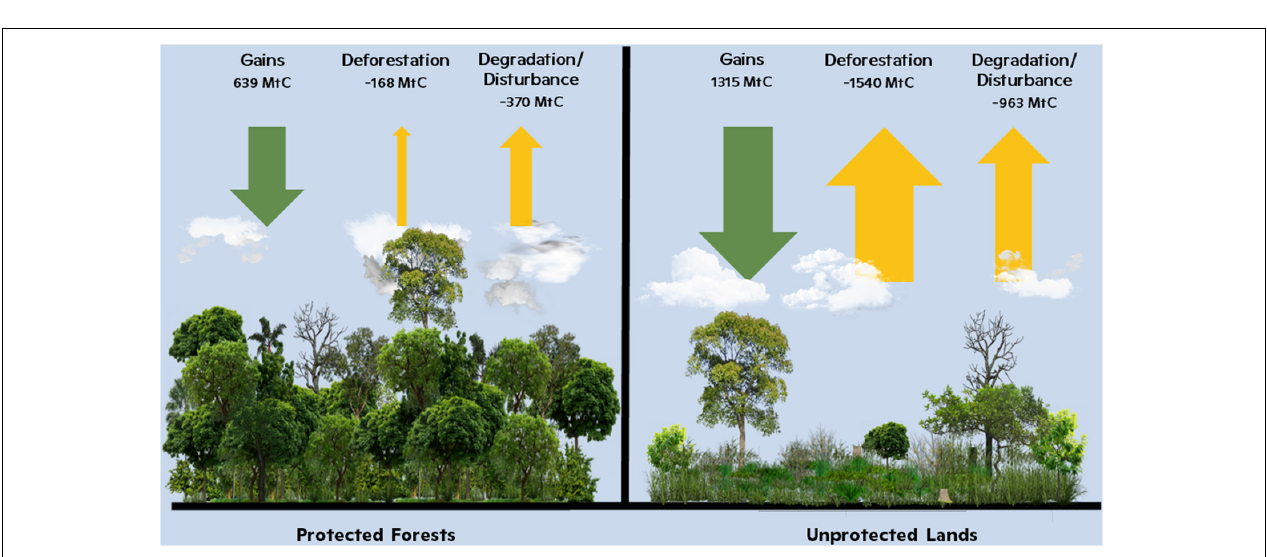
FIGURE 4 | Cumulative (gross) above-ground carbon fluxes from protected forests (left) and unprotected forests (right) between 2003 and 2019. Protected forests (i.e., Indigenous Territories and Protected Natural Areas) have higher standing carbon stocks, lower rates of deforestation (forest conversion), and less degradation/disturbance than unprotected forests (i.e., Undesignated Public Forests and Other Land). Unprotected forests had higher total carbon gains, presumably due to vegetation regrowth after disturbance, but these gains were more than offset by deforestation and